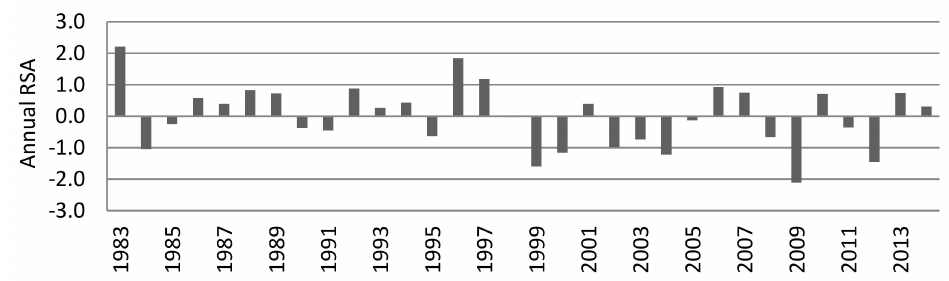
Source: Own computation from Ethiopian National Meteorological Agency data. Figure 3. Annual RF standard anomalies in the study area (1983–2014). The RF Standard Anomalies (RSA) helps to estimate the extent of drought based on the RF data [46] (Table